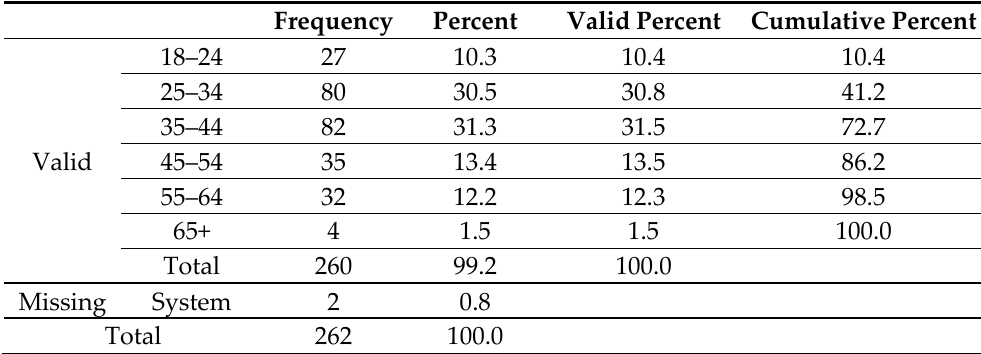
Table 2. Demographic characteristics of participants: age.